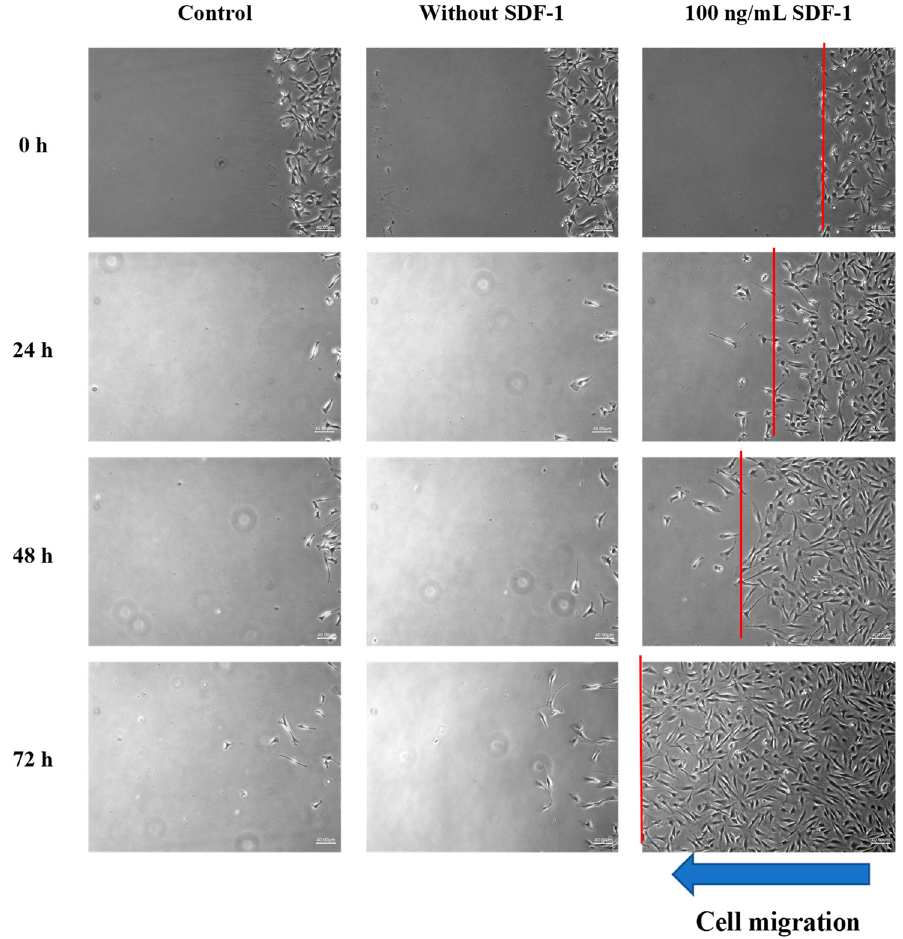
Figure 7. Mesenchymal stem cell (MSC) recruitment test (40 × ). First, second, and third columns show MSC migration of the control group, without SDF-1 group, and the 100 ng / mL SDF-1 group, respectively. The red line indicates the cell front. The results show that the MSCs of the control group and without SDF-1 group gathered together and formed colonies. MSCs of the 100 ng / mL group migrated toward the concentration gradient of SDF-1.